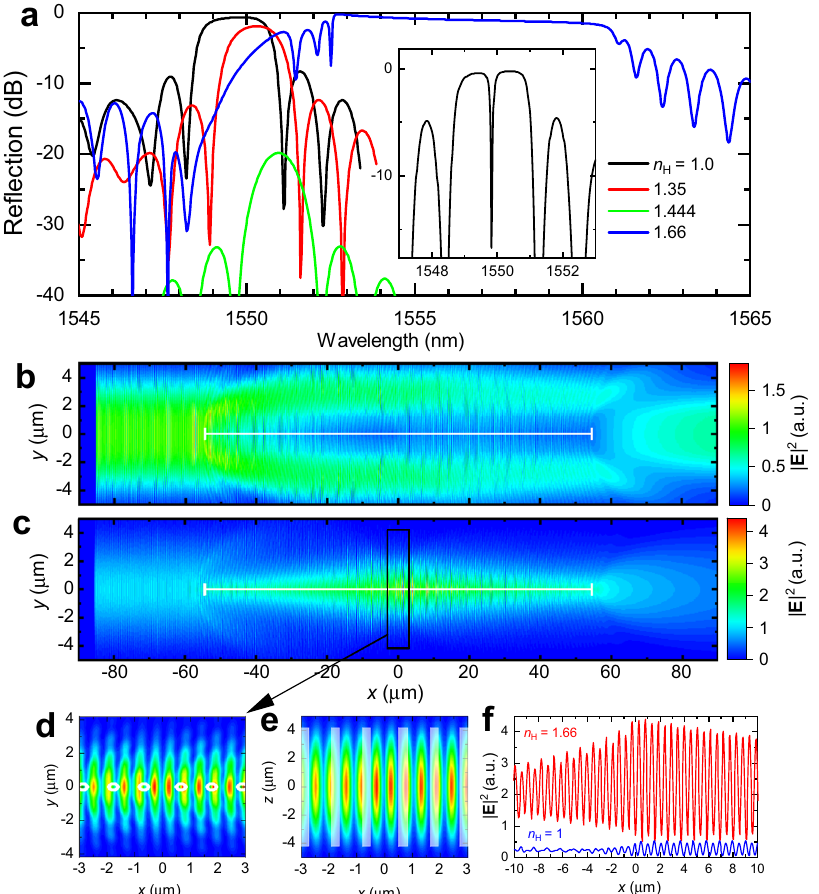
Fig. 2 Simulated spectra and light- fi eld distribution inside of the nanohole arrays. Simulated re fl ection spectra ( a ) for a second-order FBG of uniformly pitched nanoholes ( Ʌ = 1.072 μ m) having 300 nm diameter, 0.643 mm array length (600 holes) and high RI contrast ( Δ n = − 0.45 to + 0.21) when fi lled with air, solvent or oil. A sharply resolved transmission band (30 pm FWHM) has opened (inset spectrum, n H = 1) from a π -shifted FBG of 1200 holes. The simulated intensity distribution transverse to nanoholes (xy plane) for low ( n H = 1.0) ( b ) and high ( n H = 1.66) ( c ) RI cases of a π -shifted FBG (100 holes, x = − 53.6 to + 53.6 µ m). Magni fi ed views for the high RI case reveal intensity concentration in the fi lament plane ( e ) and around the π -defect ( d ; x = 0). White circles and bars outline the hole positions. Axial intensity oscillation ( x axis, y = z = 0) comparing ( f ) high and low RI